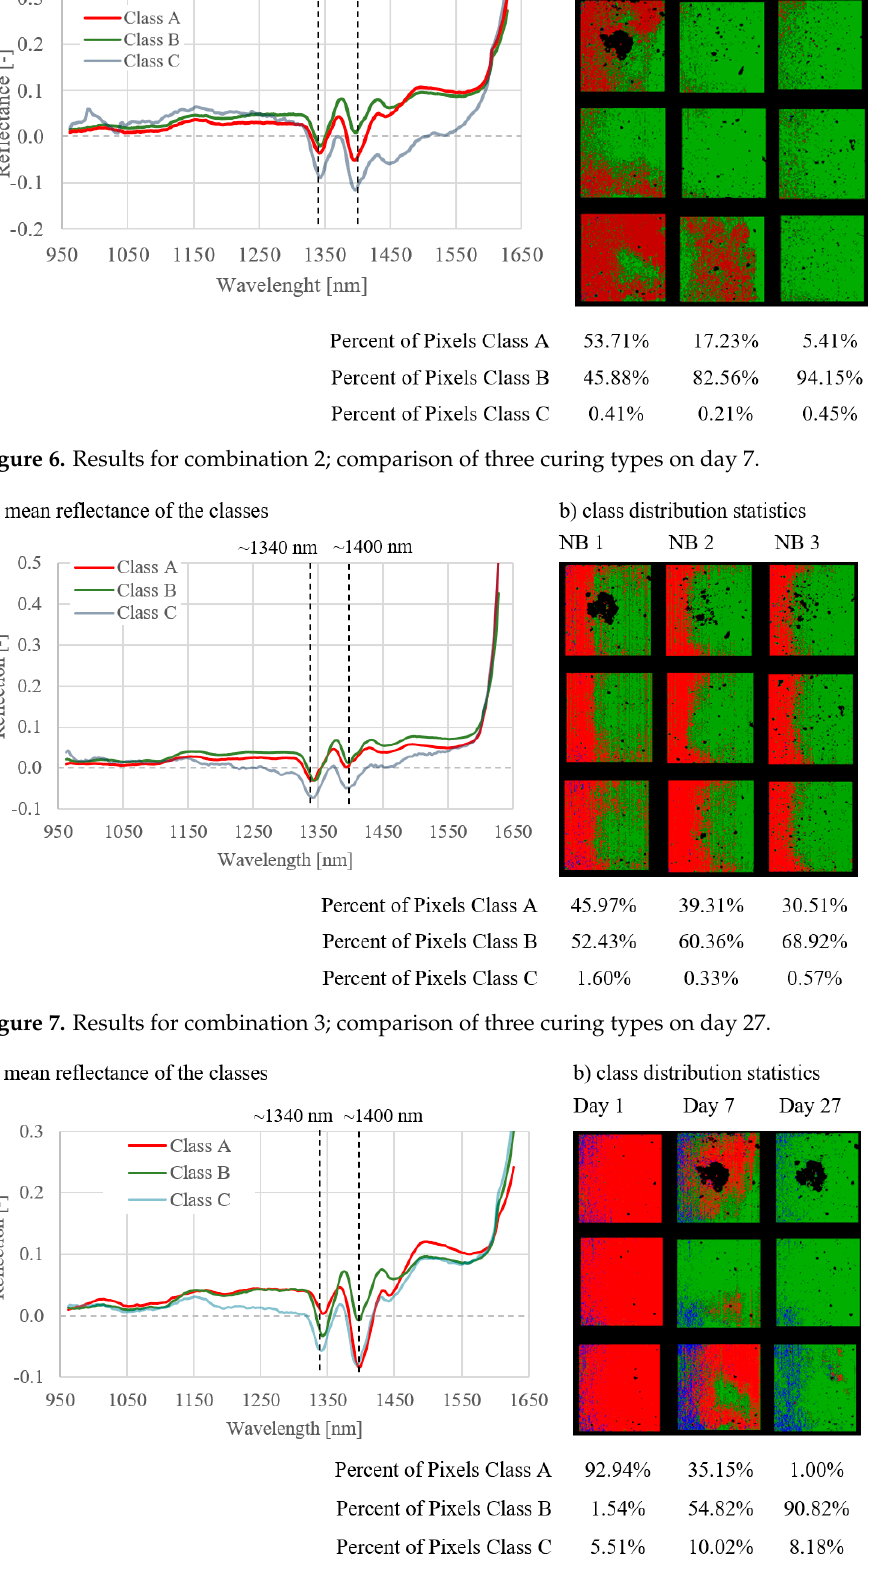
Figure 8. Results for combination 4; comparison of the measurement days of NB1 samples.